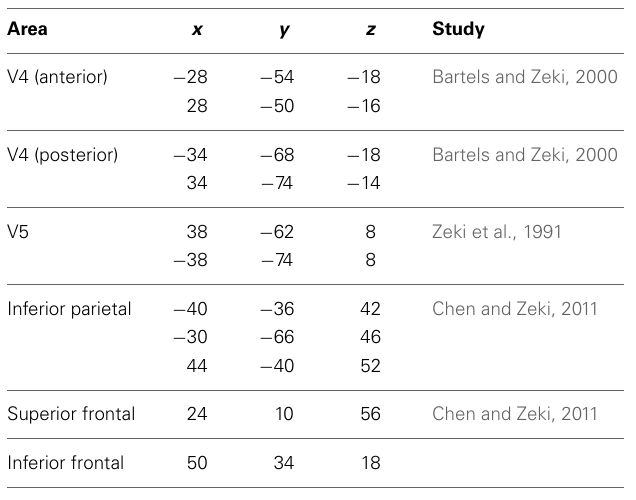
Table 1 | Coordinates (MNI) used for SVCs in areas V4 and V5, inferior parietal, and inferior and superior frontal.